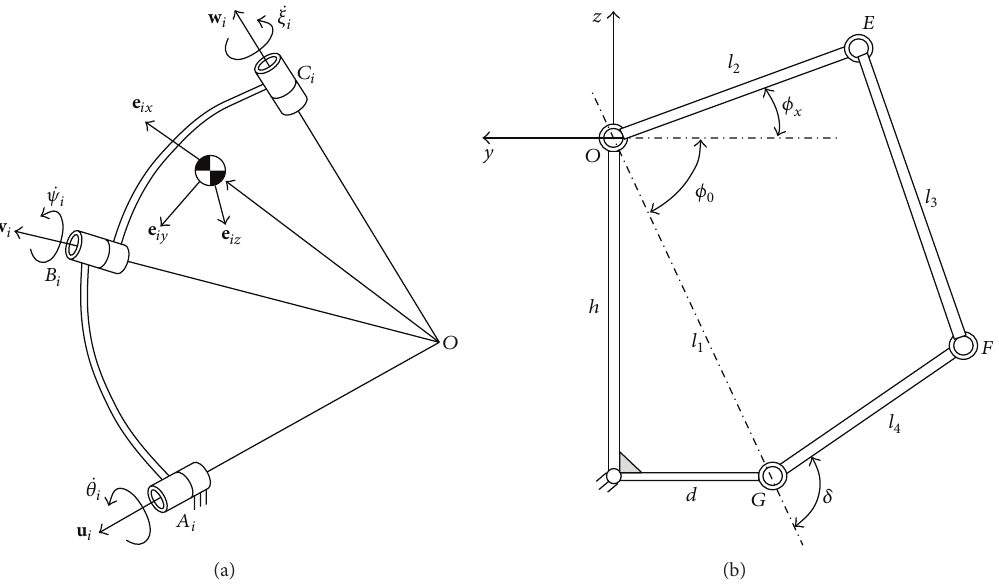
Figure 2: The motions of the legs: (a) active; (b)